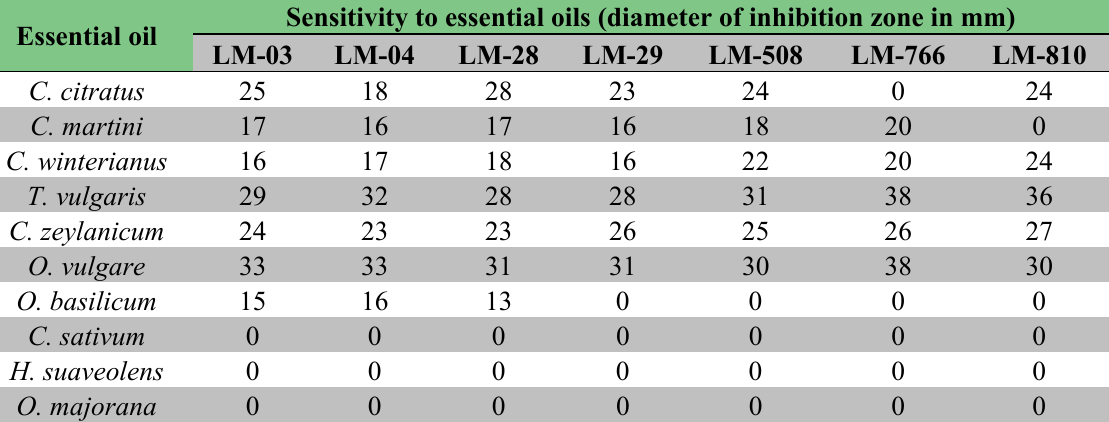
Table 2. Antifungal activity of essential oils against strains of R. oryzae. Sensitivity to essential oils (diameter of inhibition zone in Essential oil